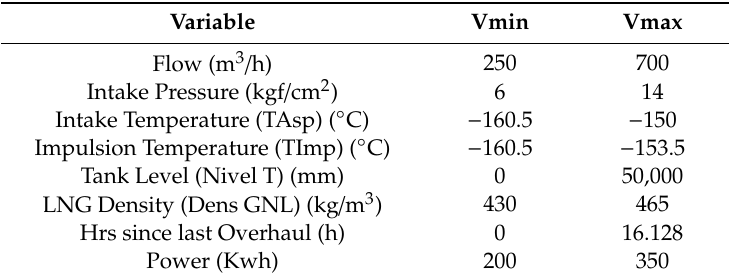
Table 4. Values for data normalization.